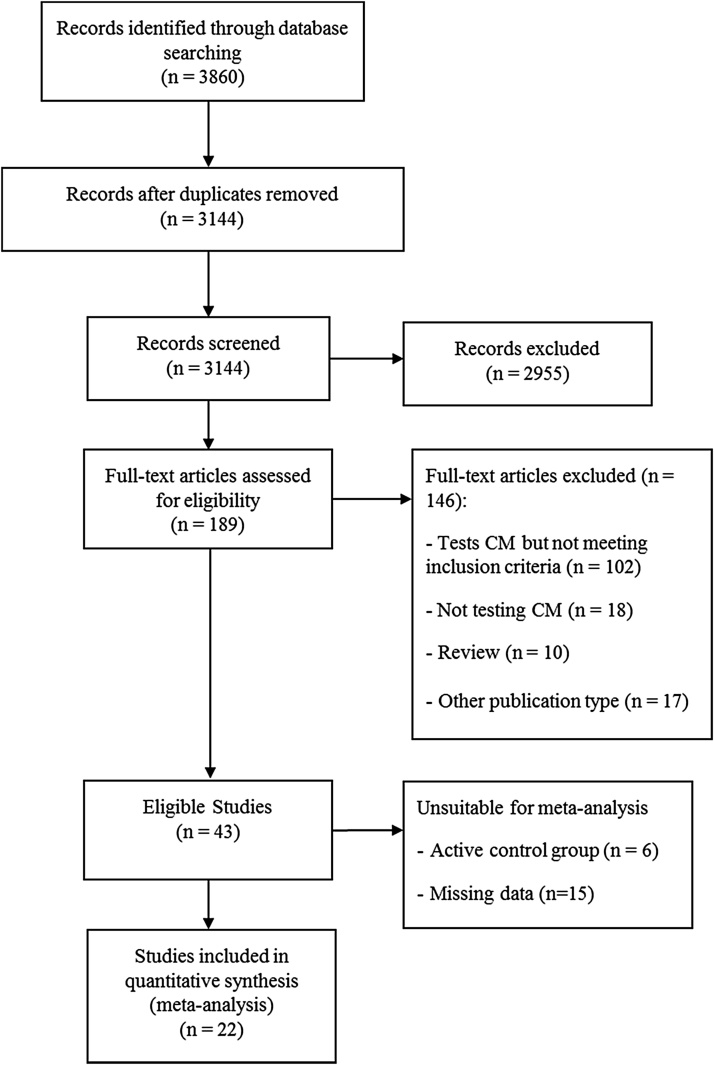
PRISMA flow diagram.